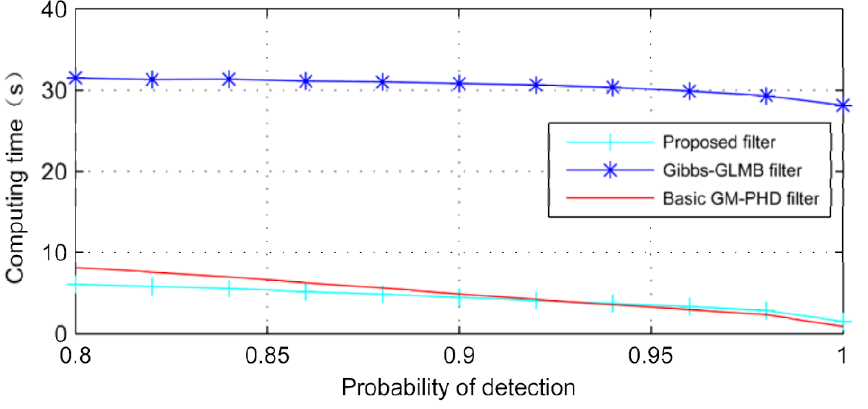
Figure 10. Computing times of different algorithms under various probabilities of detection for 250 sample runs ( λ = 100